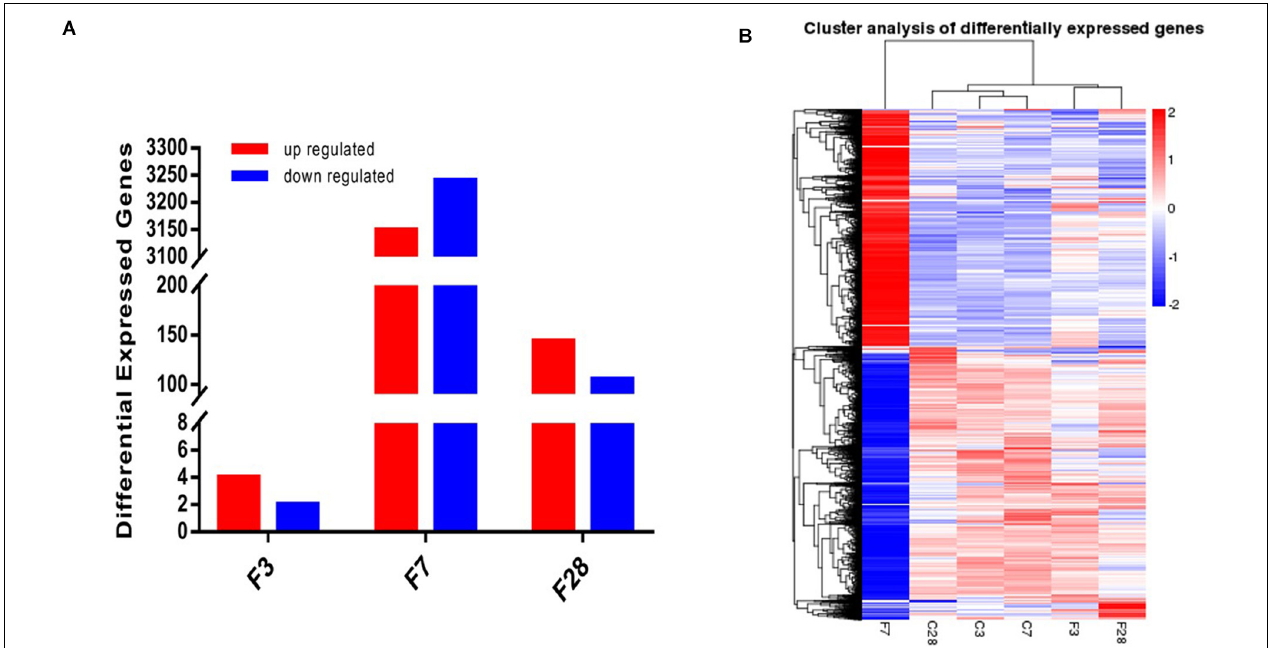
FIGURE 7 | Whole transcriptome analysis of lungs exposed to influenza virus/saline showing (A) 6, 6389 and 249 DEGs in the H1N1-infected mice on 3, 7, and 28 dpi, and (B) gene clustering based on expression levels (FPKM). Blue color indicates the low-expressed-level genes and red color the high-expressed-level genes in the whole data set (C, the group treated with saline; F, the group treated with influenza virus; the number followed C/F represented the day post inoculation. n = 3 per